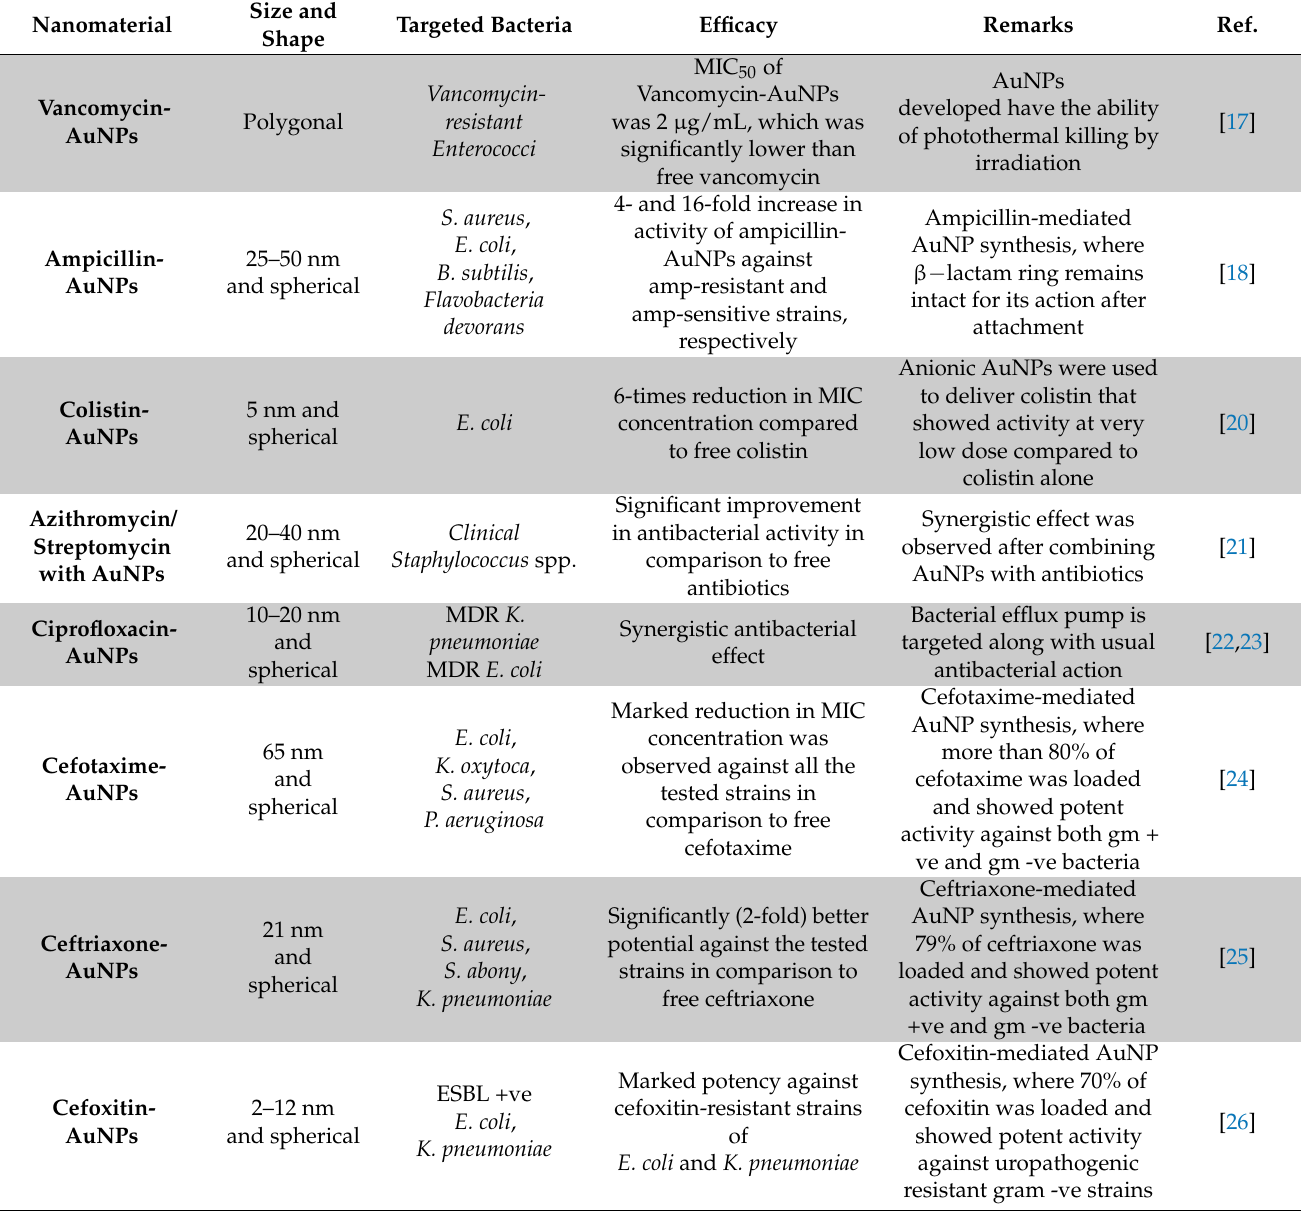
Table 1. Antibiotic-loaded AuNPs against different bacterial